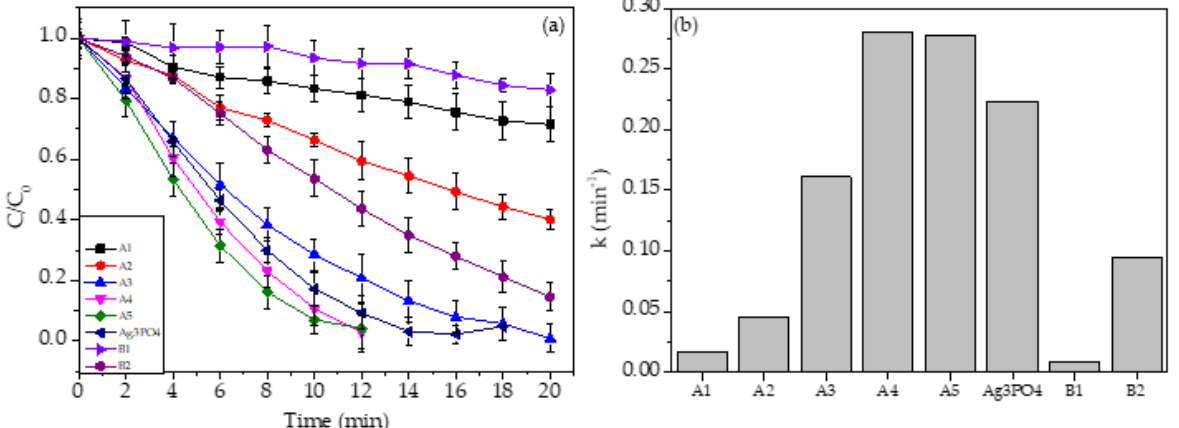
Figure 7. ( a ) Photocatalytic performance and ( b ) the rate constant of Ag 3 PO 4 /TiO 2 @Ti 3 C 2 composite (samples A1, A2, A3, A4, and A5), pure Ag 3 PO 4 , TiO 2 @Ti 3 C 2 (B1), and Ag 3 PO 4 /TiO 2 P25